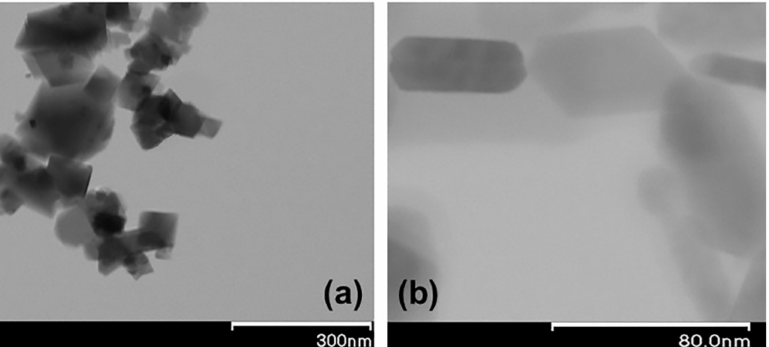
Figure 4. TEM image of uncovered MNP ( a ) and stabilized magnetic nanoparticles MNP-AIm_2 ( b ), obtained by depositing 10 µ L of a suspension of each sample onto a copper grid coated with a thin carbon film and drying